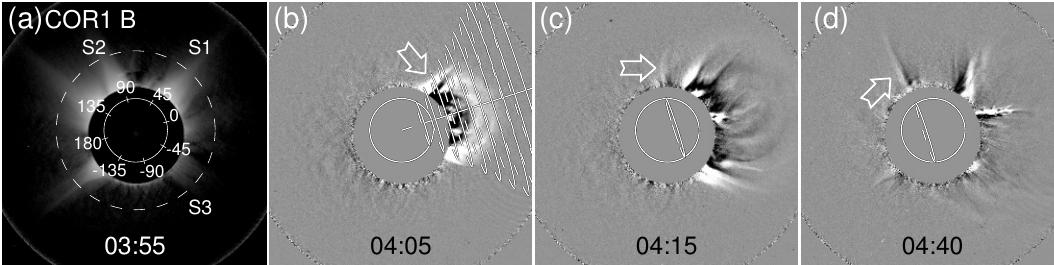
Figure 8: White-light observations (with STEREO/COR1-B) of the upper coronal counterpart of the coronal EUV wave of 2011 Aug 4. Panel (a) shows a total brightness image, while panels (b)–(d) are running difference images. The cone in panel (b) represents a CME model. An arrow indicates the WL wavefront that is propagating counter-clockwise. Image reproduced with permission from Kwon et al. (2013b), copyright by